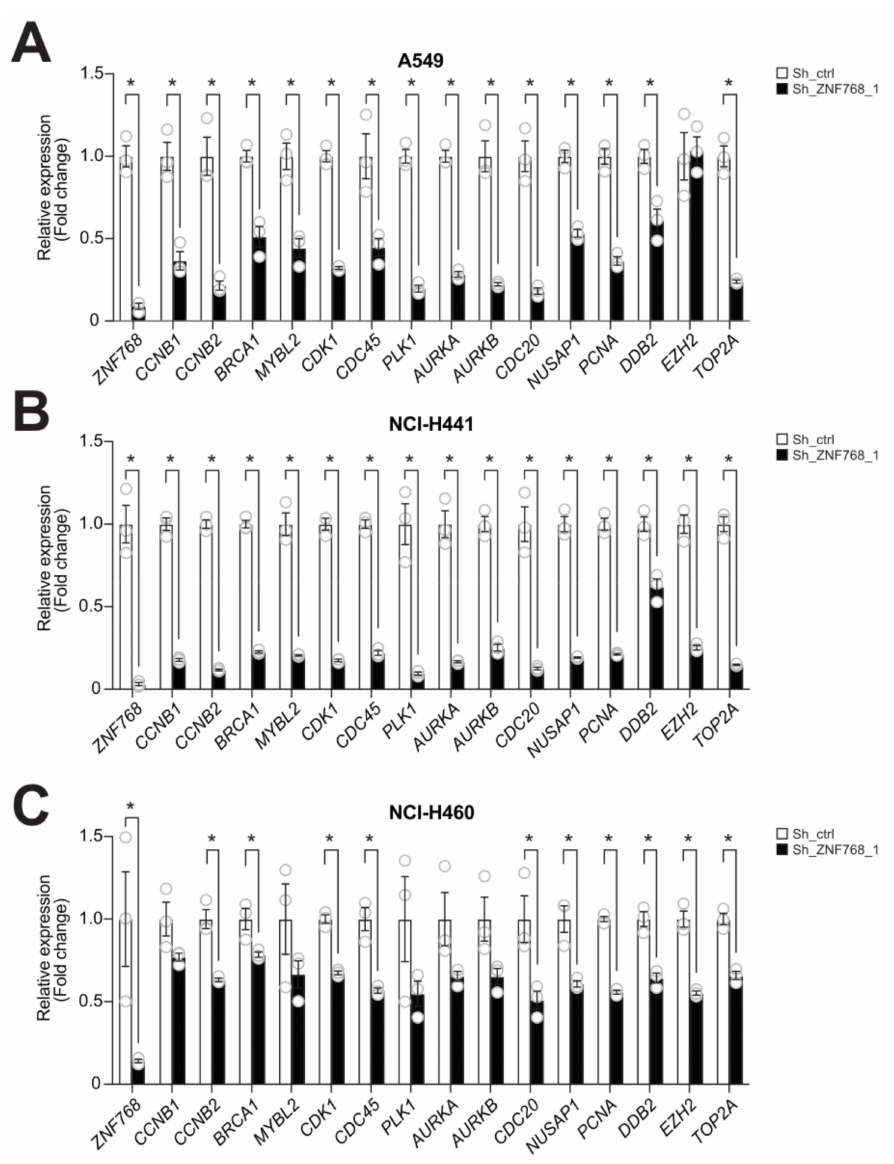
Figure 4. ZNF768 depletion alters the expression of key genes regulating proliferation in lung cancer cells. ( A ) A549 cells, ( B ) NCI-H441 and ( C ) NCI-H460 cells were transduced with lentivirus expressing shRNA targeting ZNF768 and were selected with puromycin. RNA was